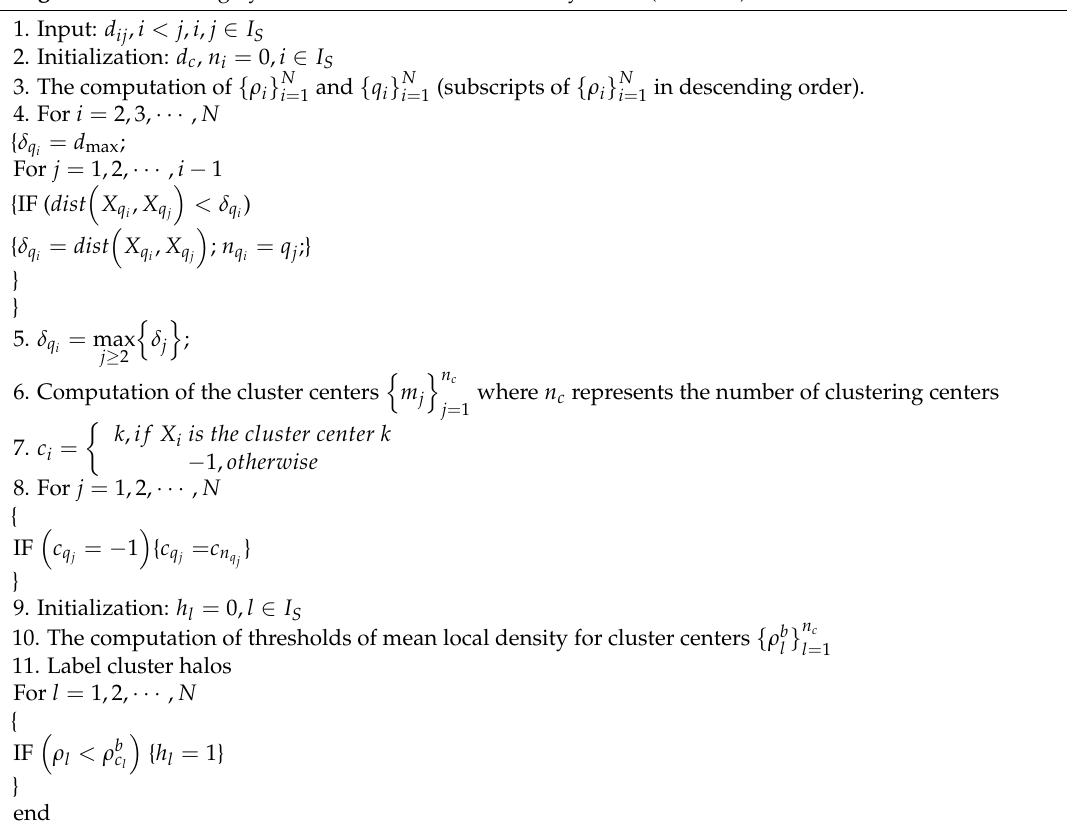
Table 1. The steps for the CFSFDP algorithm [35–37]. Algorithm Clustering by Fast Search and Find of Density Peaks